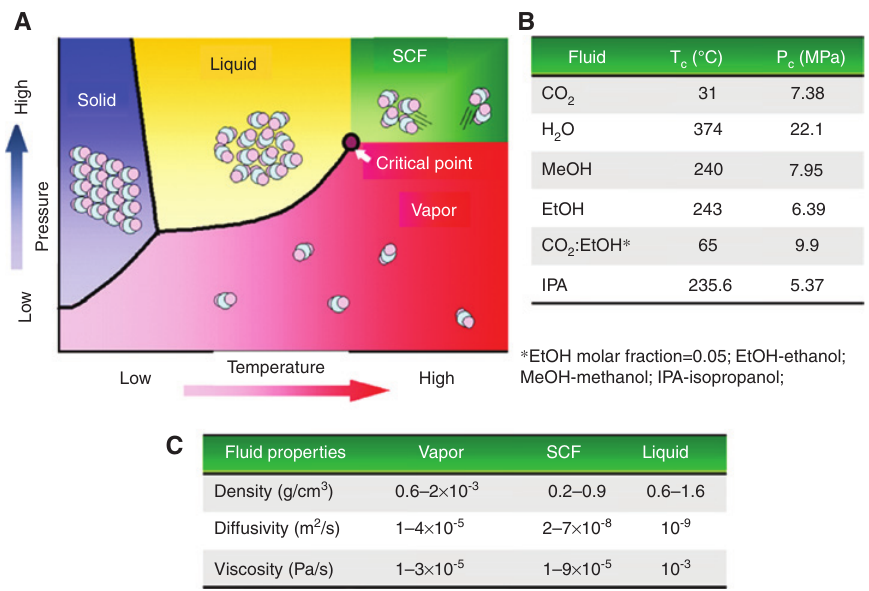
Figure 1: Pressure-temperature phase diagram (A) with the critical data of some fluids [NIST database] (B) and the comparison of typical properties of vapor, supercritical fluid and liquid (C)